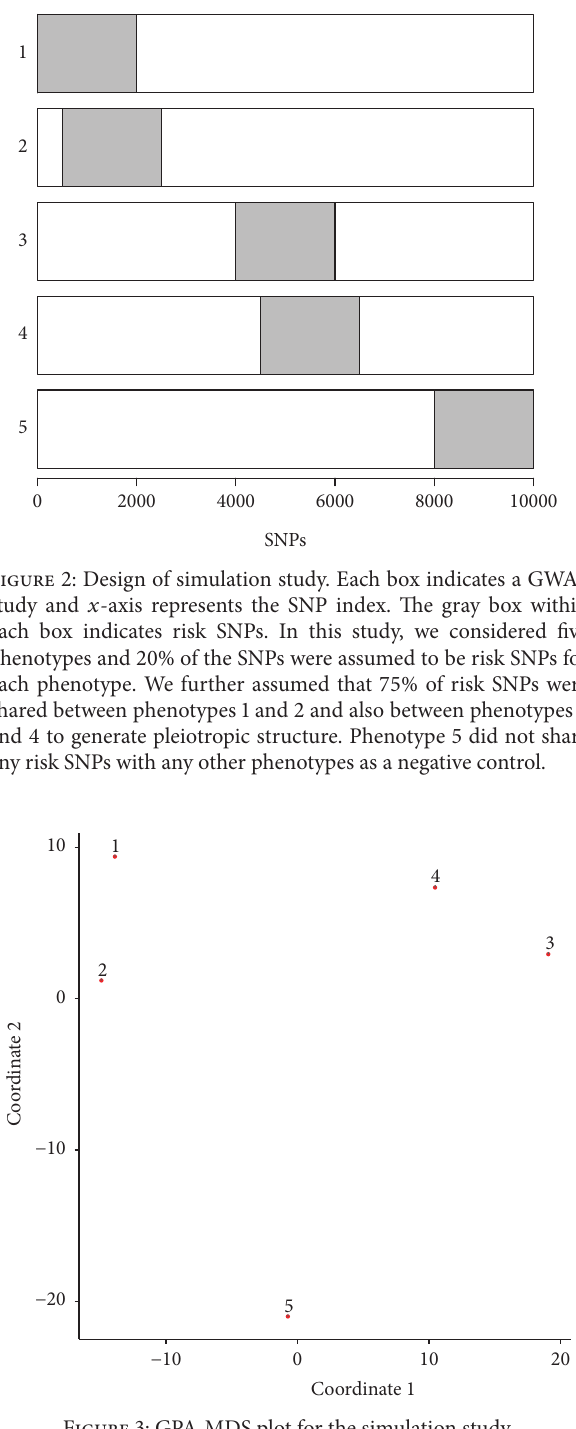
(Figure 2). Finally, for each phenotype, we simulated 𝑝 -values for nonrisk SNPs from a uniform distribution and 𝑝 -values for risk SNPs from a Beta distribution with parameters 0.4